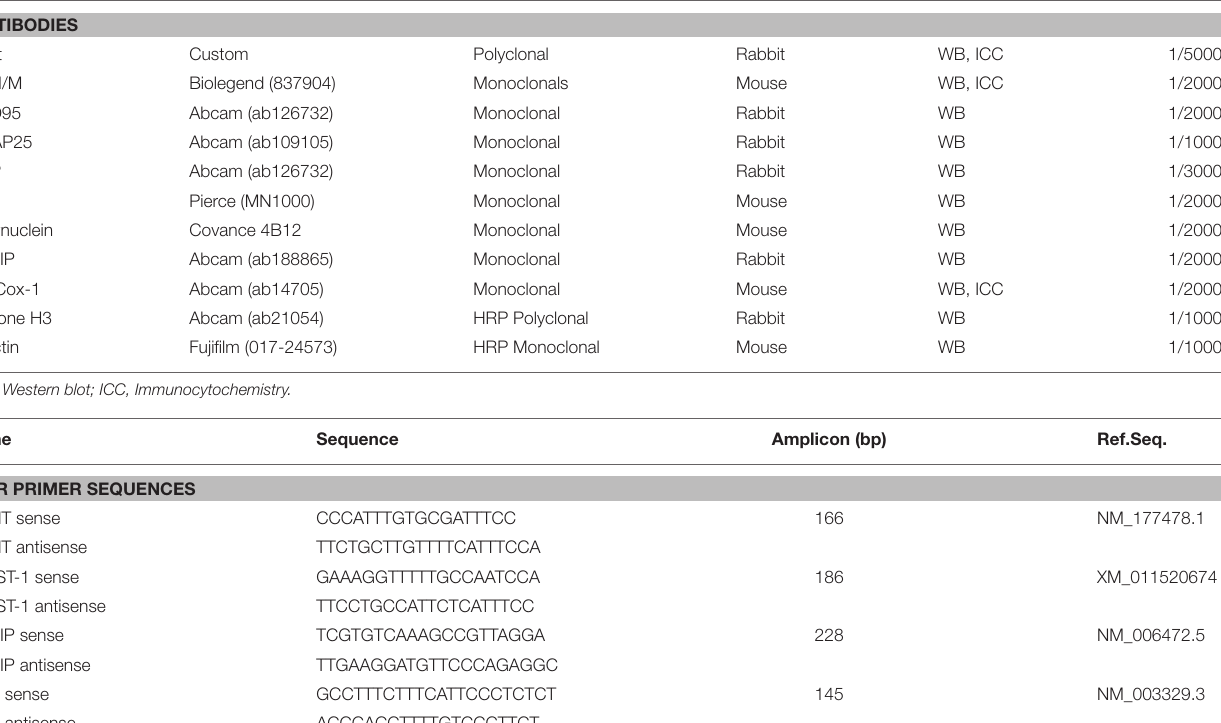
TABLE 1 | Description of reagents used in study.